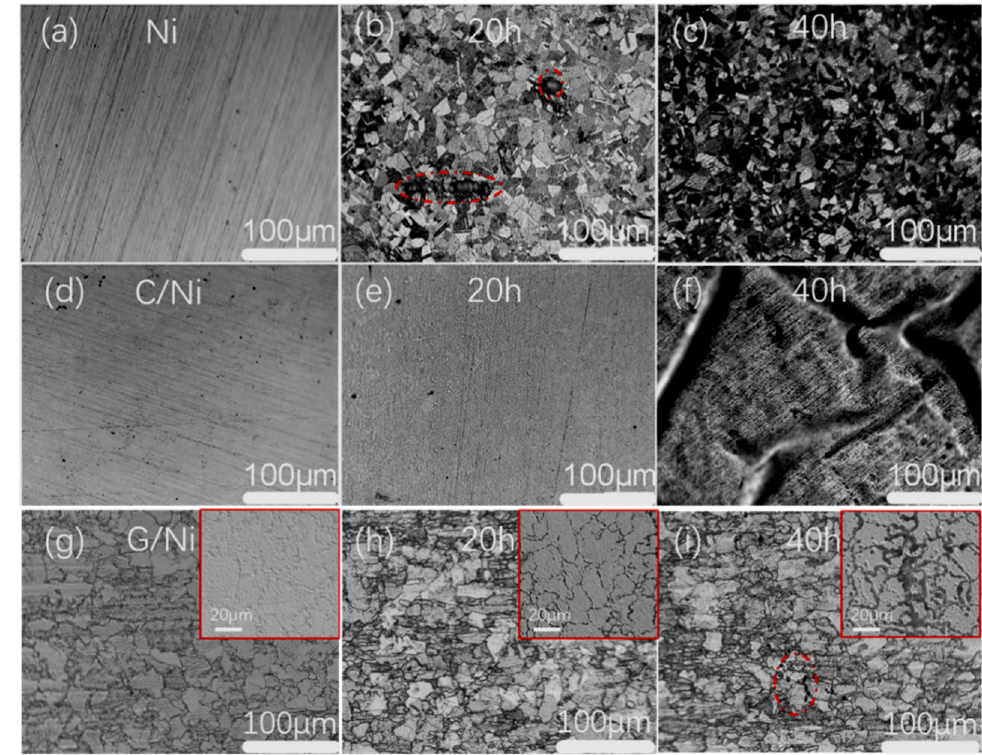
Figure 7. Optical images of the sample surface: bare Ni before ( a ) and after the immersion test for 20 h ( b ) and 40 h ( c ); C/Ni-10 before ( d ) and after the immersion test for 20 h ( e ) and 40 h ( f ); G/Ni-10 before ( g ) and after the immersion test for 20 h ( h ) and 40 h ( i ) together with their inset SEM images.